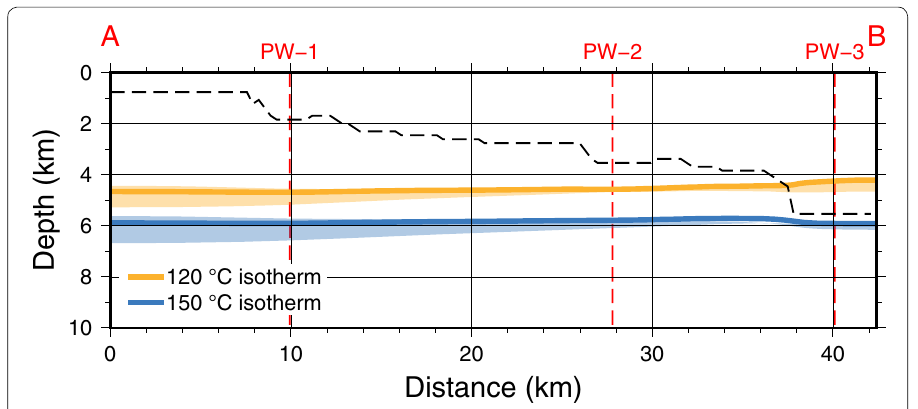
Fig. 11 Depth of 120 °C and 150 °C isotherms along profile A–B. Depth of 120 °C and 150 °C isotherms along profile A–B for the modeled scenarios. Lines are isotherm for Model 1 and light shadow areas indicate the min–max range given by Models 2, 3, and 4. The black dashed line is the depth to basement profile and PW-1, PW-2, and PW-3 are virtual wells used